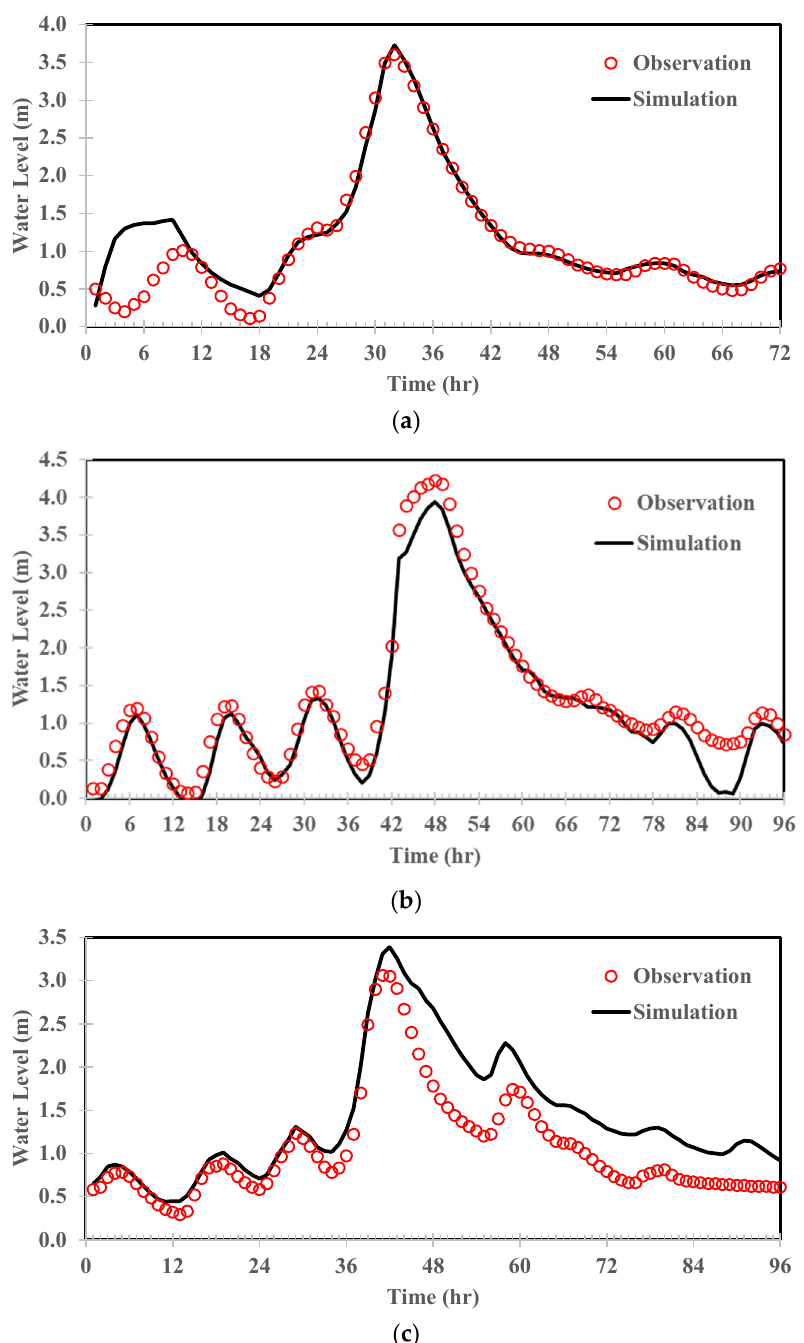
Figure 8. Comparison of the simulated and observed water levels at YR_R2 for ( a ) Typhoon Soulik; ( b ) Typhoon Dujuan; and ( c ) Typhoon Megi.